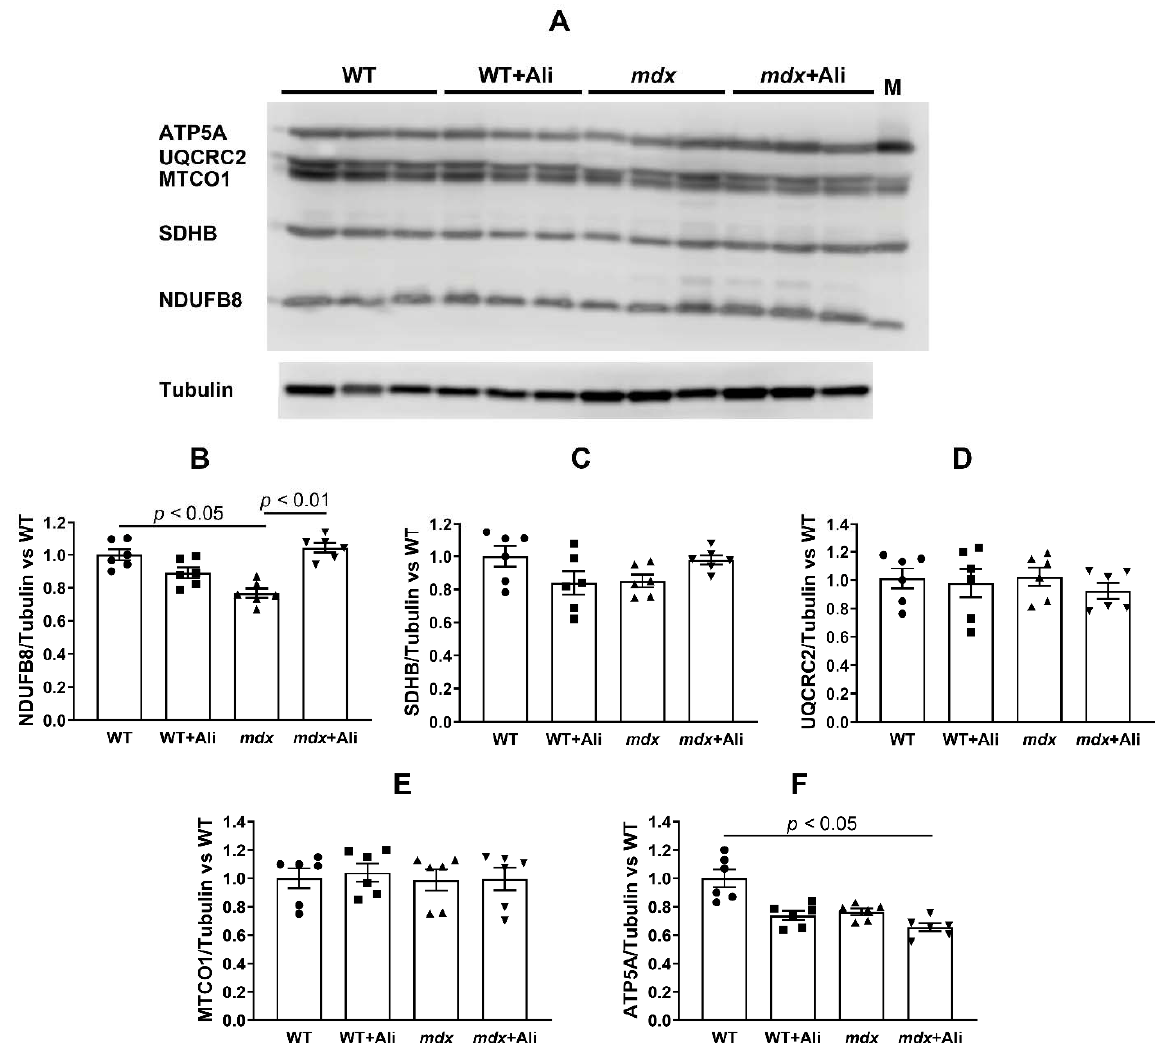
Figure 7. The effect of alisporivir on the content of the proteins of mitochondrial respiratory chain complexes. Data of Western blot analysis ( A ). The letter “M” indicates a positive control (rat heart tissue lysate; mitochondrial extract). Quantification of complex I/tubulin ratio ( B ), complex II/tubulin ratio ( C ), complex III/tubulin ratio ( D ), complex IV/tubulin ratio ( E ), and complex V/tubulin ratio (ATP synthase) ( F ). The data are presented as means ± SEM ( n = 6). Table 1. The effect of alisporivir treatment on the parameters of respiration and oxidative phosphorylation of skeletal muscle mitochondria of studied groups of